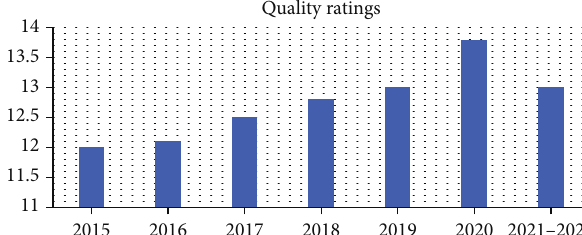
Figure 10: Mean quality rating per